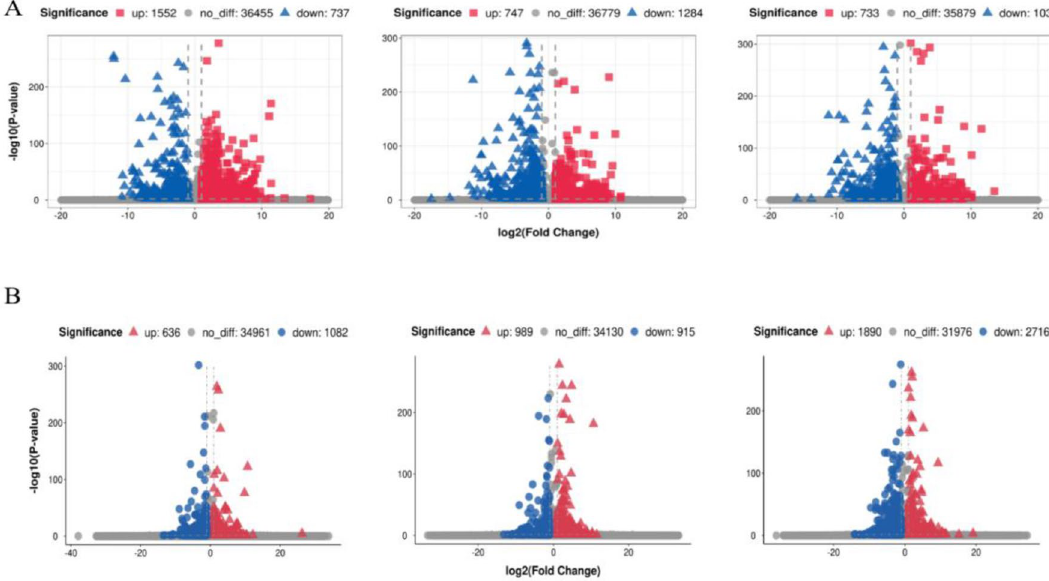
Figure 3. Volcano diagram of genes expression of grape and peach in three periods. ( A ) Grape ‘Pinot Noir’ and ‘Changbai No. 9’. ( B ) ‘Okubo’ and ‘Lianyungang Maotao’ From left to right are the Volcano diagrams of the gene expression of grape and peach in the young fruit stage, swelling stage, and mature stage; the abscissa is log 2 (Fold Change), and the ordinate is -log 10 ( P -value); up: significantly up-regulated gene, down: significantly down- regulated gene, no_diff: no significant change in